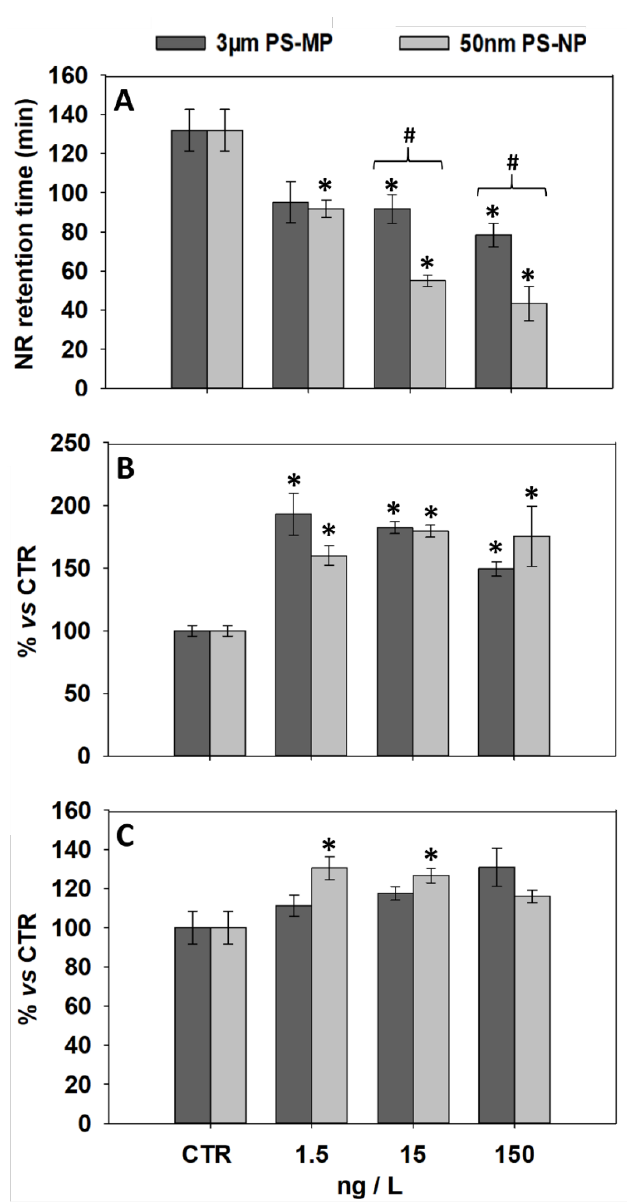
Figure 1. Lysosomal parameters (mean ± SEM, N = 3) analyzed in mussels after 21 days of exposure to polystyrene microplastics (PS-MP) and polystyrene nanoplastics (PS-NP); ( A ), Lysosomal Membrane Stability (LMS) assessed in mussel hemocytes; ( B ), lysosomal content of unsaturated neutral lipids (NL) in mussel digestive gland; ( C ), lysosome to cytoplasm volume ratio (LYS/CYT) in mussel digestive cells. *, significant ( p < 0.05) differences compared to control samples (CTR); #, significant differences ( p < 0.05) between PS-MP and PS-NP